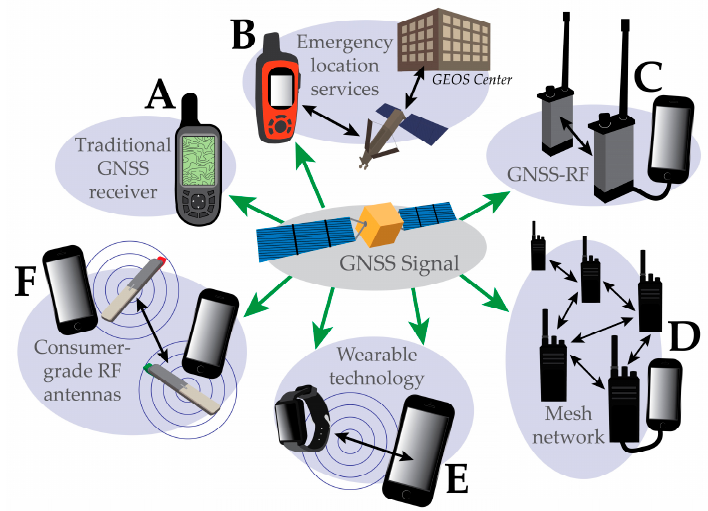
Figure 2. Common types of available technologies for real-time location sharing in remote areas.